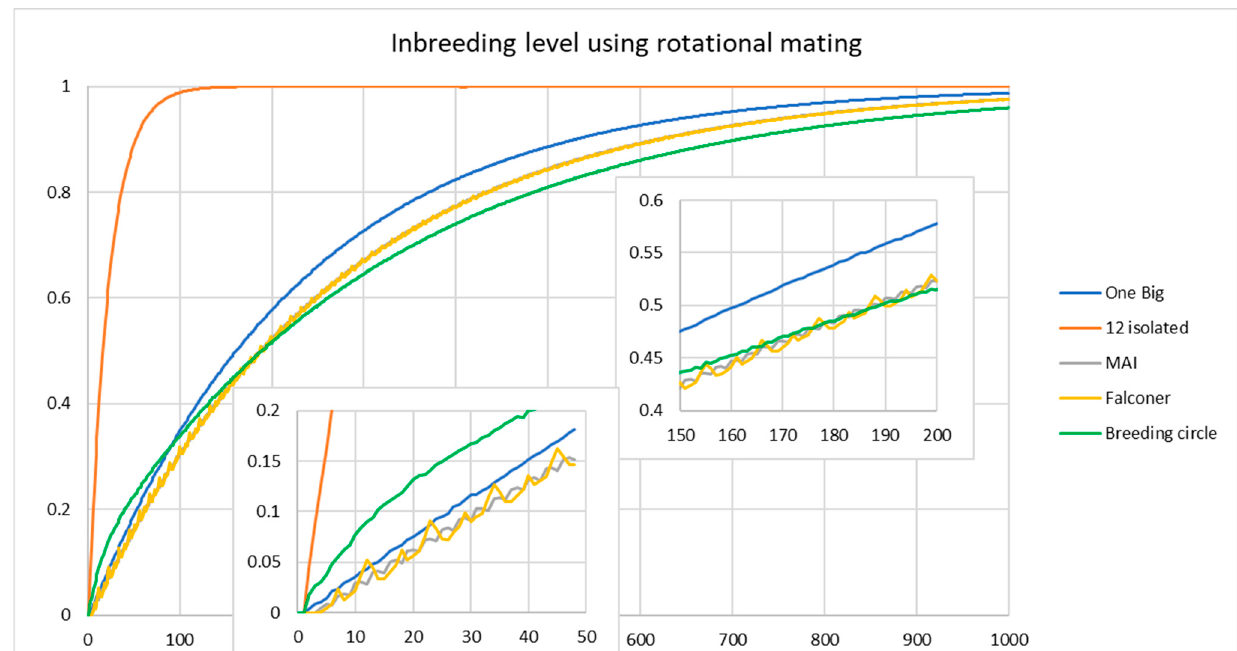
Figure 6. Inbreeding levels for 1 large group consisting of 24 males and 144 females (blue line) compared to 12 groups with 2 males and 12 females each, either without exchange between groups (orange line) or with systematic exchange of all new born males under 3 breeding schemes (details in Figure 5). Inbreeding levels are average of 50 simulation replicates performed with the pointer software.